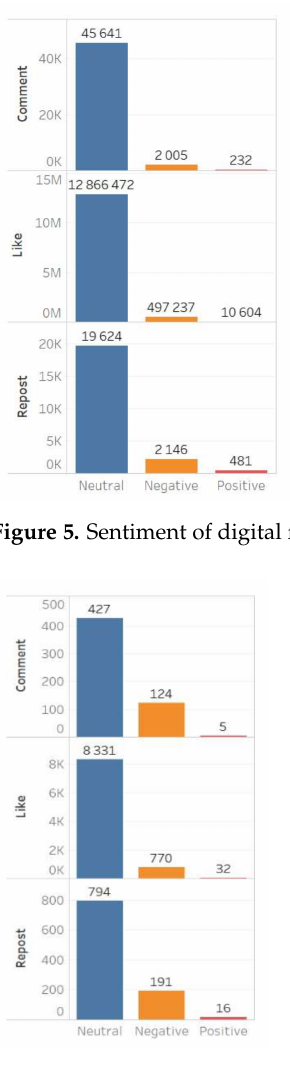
Figure 6. Sentiment of digital footprints of the Moscow actors’